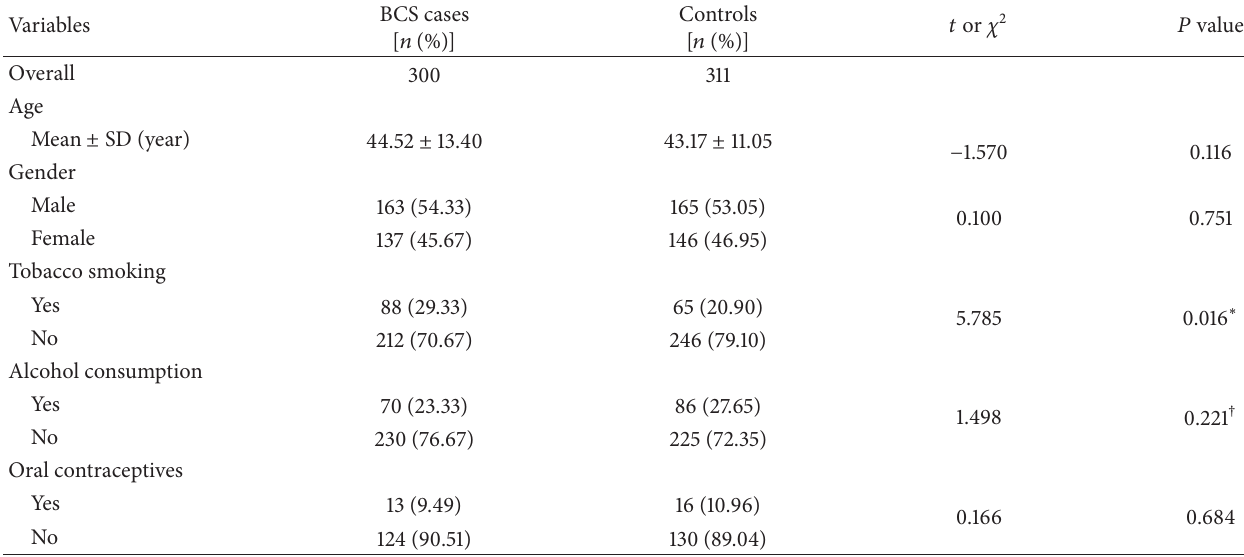
Table 1: Baseline characteristics of enrolled cases and controls.